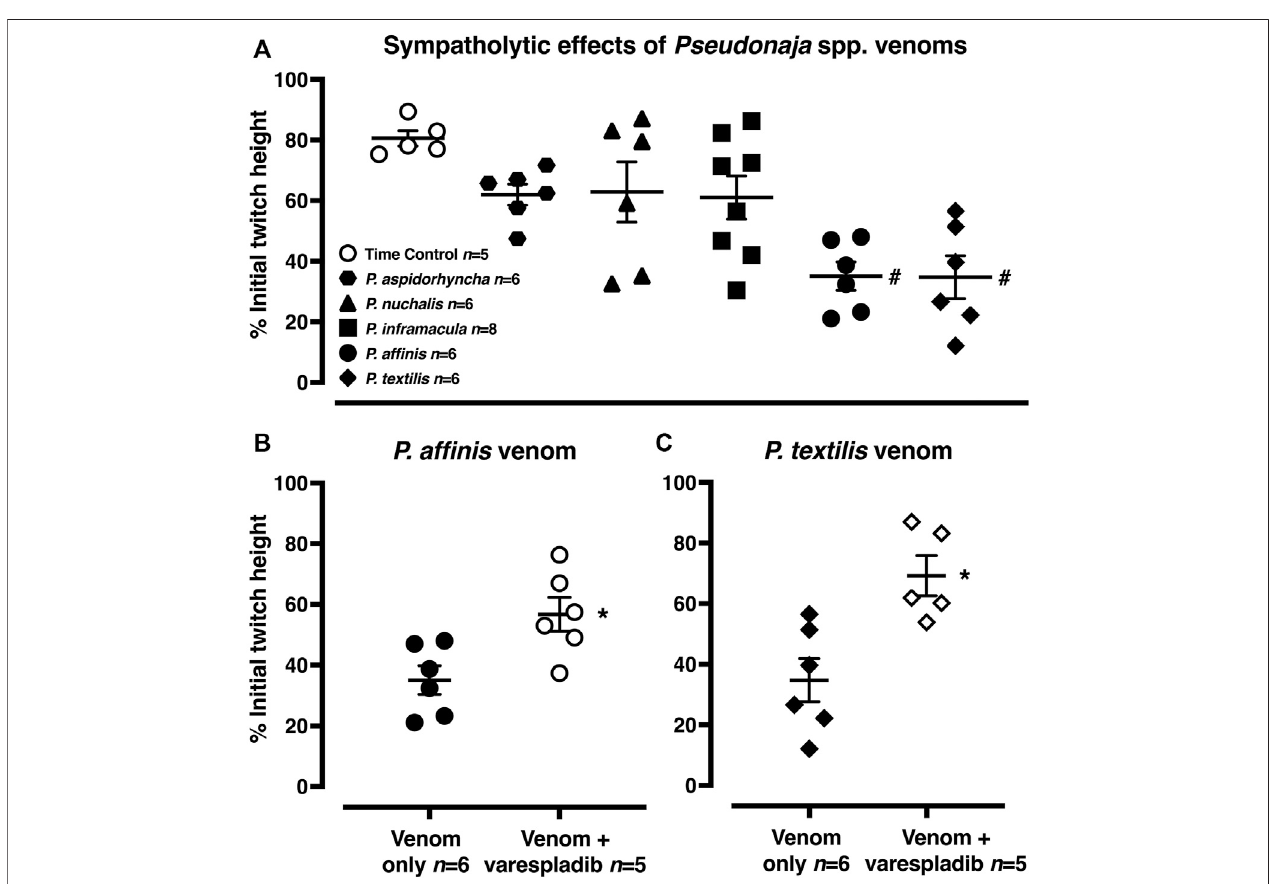
FIGURE 5 | (A) Sympatholytic effects of fi ve Pseudonaja spp. venoms (30 µg/ml each) 20 min after administration in rat isolated electrically stimulated small mesenteric arteries. (B) The sympatholytic effects of P. af fi nis and (C) P. textilis venoms (30 µg/ml) in the absence (venom only) or presence of varespladib (1 µM). Responses are expressed as % of the initial electrically induced contractile twitch height (at 0 min) and individual values are shown. Horizontal bars represent the mean and vertical bars ± 1 SEM of n arteries from separate rats. # p < 0.05 vs time control, one-wayANOVA with Dunnett ’ s post hoc test. * p < 0.05 vs. respective venom only groups, unpaired Student ’ s t